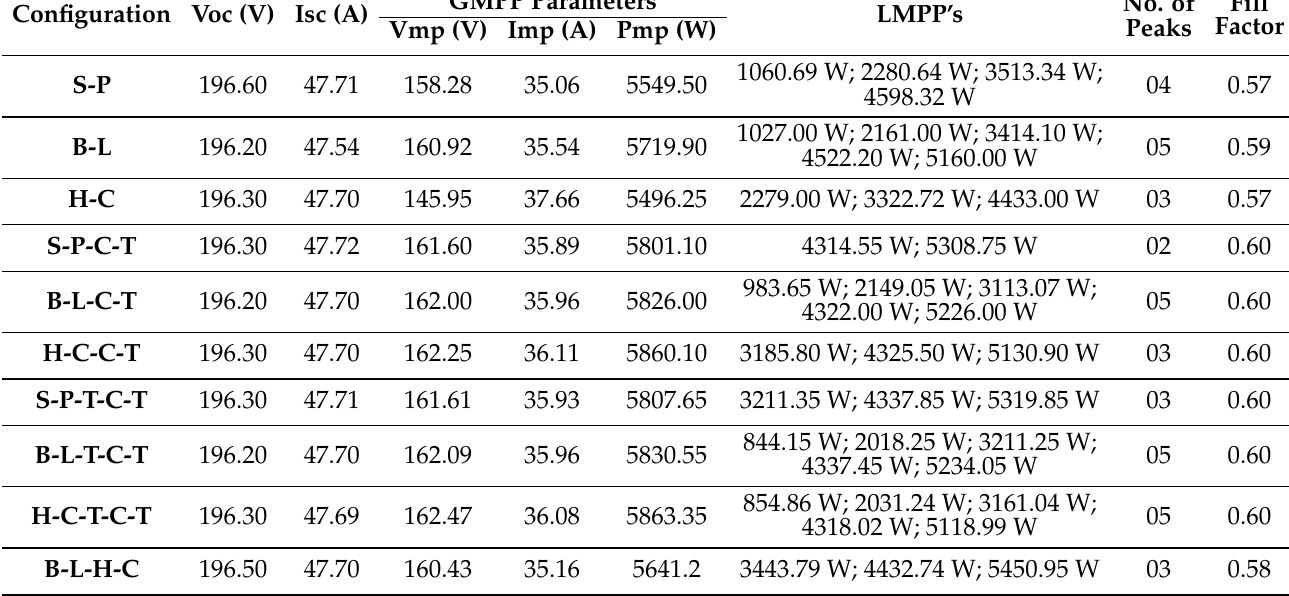
Table 7. Parameter variations of conventional and hybrid array configurations under LAN